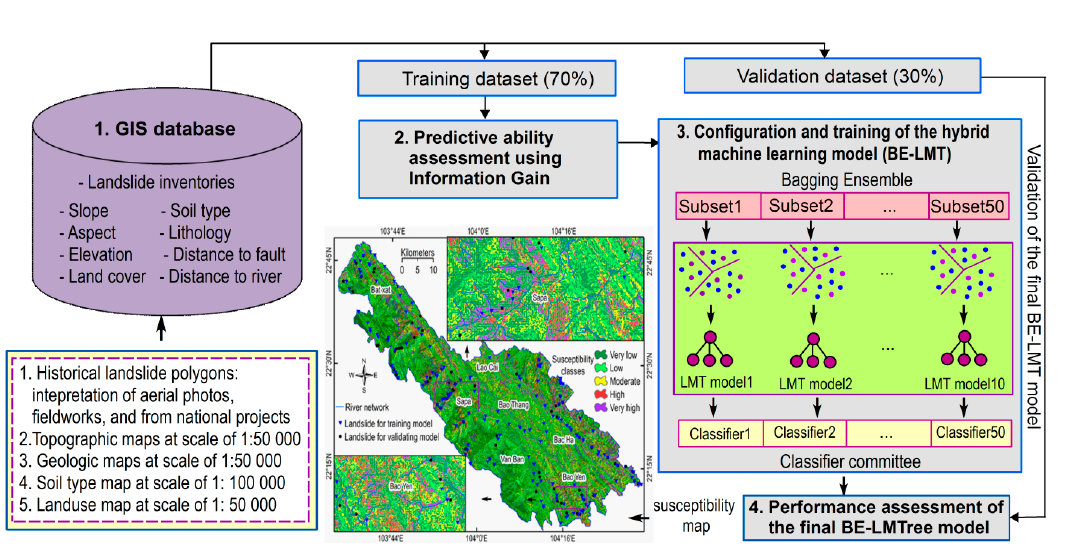
Figure 5. Methodological concept of the proposed Bagging ensemble (BE)-Logistic Model Trees (LMTree) model used in this study.